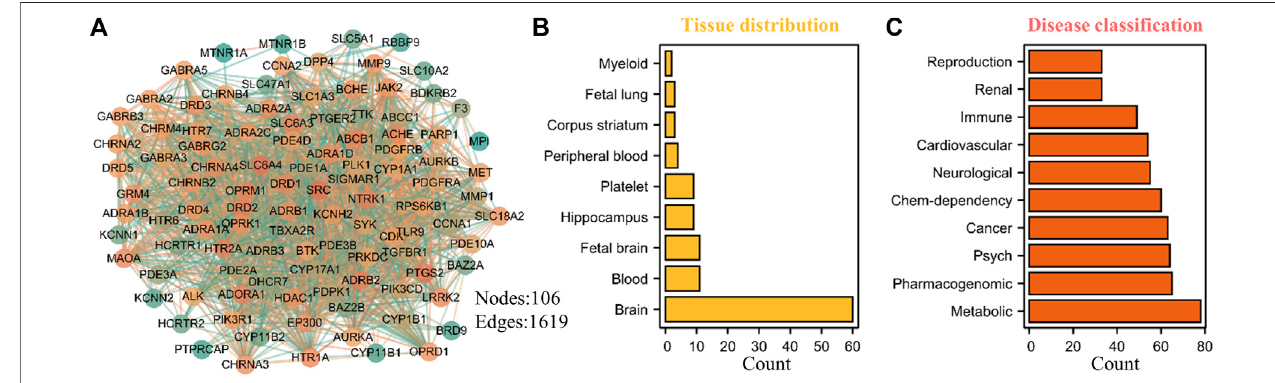
FIGURE 9 | Potential target prediction, tissue distribution and disease type enrichment analysis of THP. (A) A total of 106 targets were predicted by SwissTargetPrediction database (http://www.swisstargetprediction.ch/). (B – C) The tissue distribution and disease type enrichment analysis of THP using DAVID database. The data obtained from the following websites: